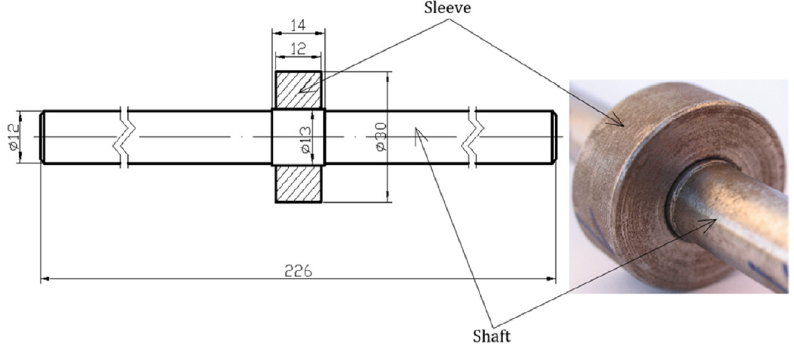
Figure 1. Sample diagram with dimensions [27,28].